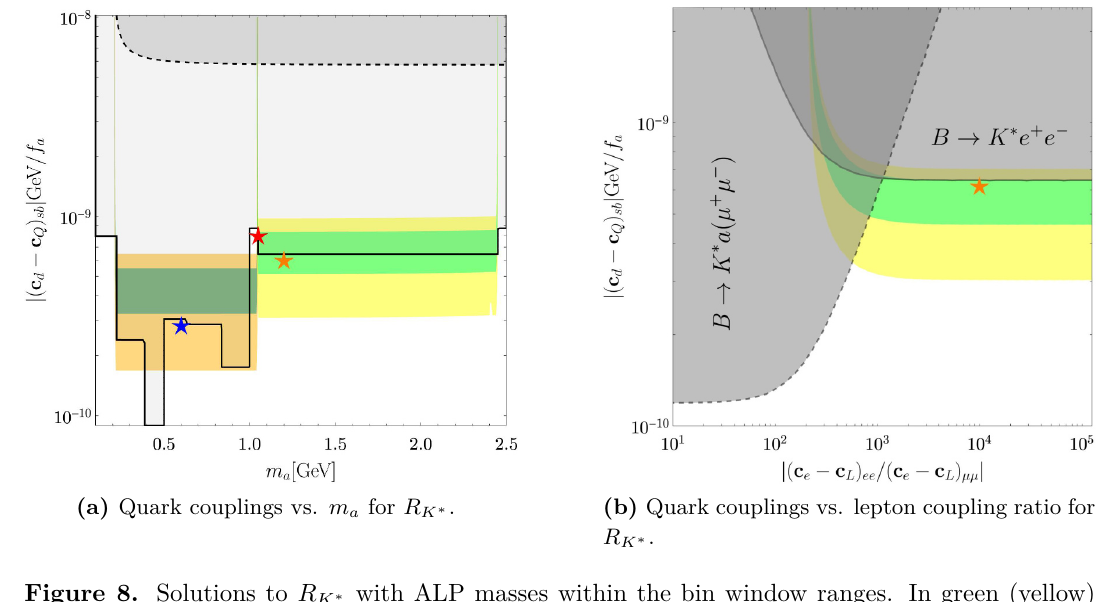
Figure 8. Solutions to R K ∗ with ALP masses within the bin window ranges. In green (yellow) the 1 σ (2 σ ) solutions to the central bin. The coloured stars correspond to the benchmark ALP- lepton couplings ( | ( c ) ( c ) ) = (10 − 1 , 10 − 5 ) GeV − 1 , for different values of e − c L ee | /f a , | e − c L µµ | /f a m a . On the left: parameter space of ALP-quark couplings vs. m a excluded by B → K ∗ µ + µ − data (enclosed by the dashed line) and by B → K ∗ e + e − data (enclosed by the solid line). For m a ∈ [0 . 39 , 0 . 5] GeV data show a tension of more than 2 σ with respect to the SM prediction and the additional contribution of the ALP could only worsen it (see figure 16). The dark green (dark yellow) shaded areas indicate ALP solutions to R low bin at 1 σ (2 σ ) . On the right: constraints K ∗ from semileptonic B -decays on the parameter space of ALP couplings to quarks and leptons, for the reference value m = 1 . 2 GeV. In grey the regions excluded by B → K ( ∗ ) µ + µ − data (enclosed a by the dashed line) and B → K ( ∗ ) e + e − data (enclosed by the solid